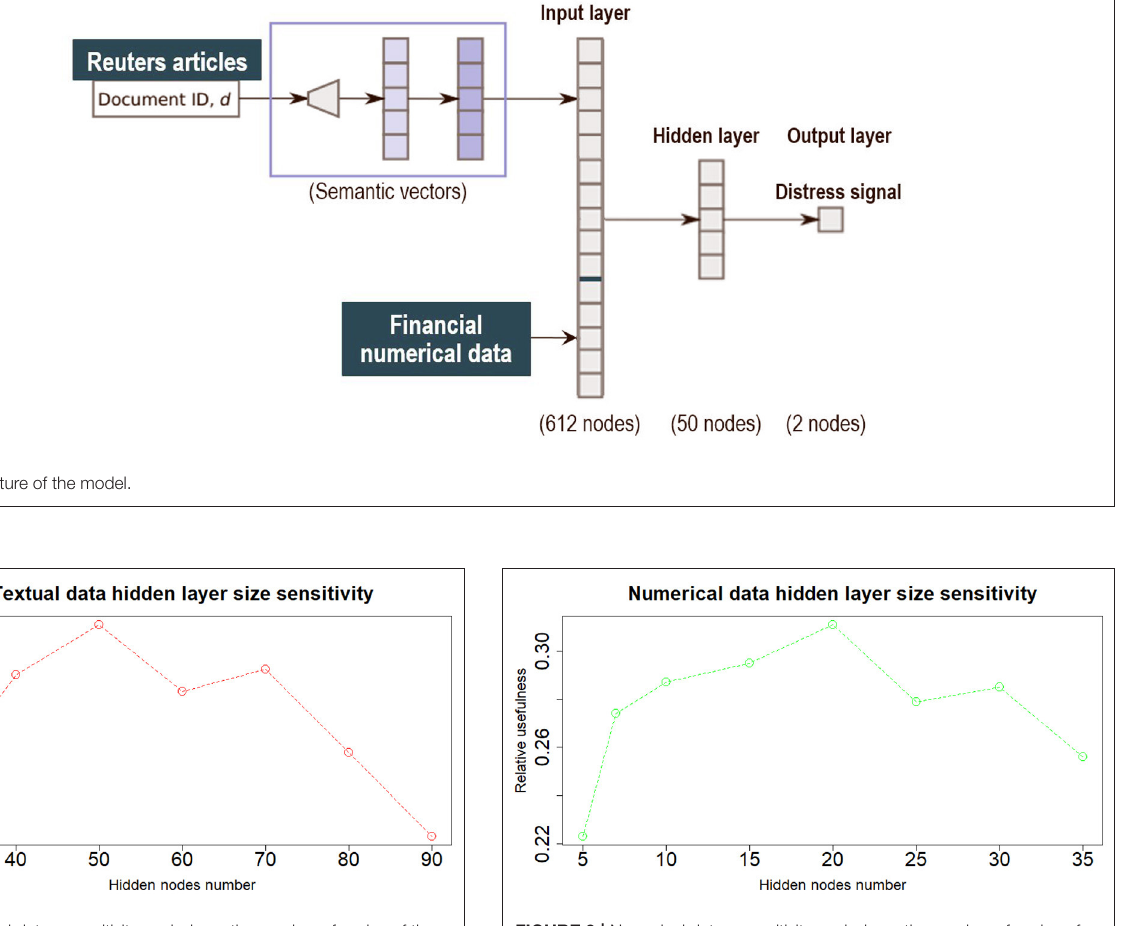
FIGURE 2 | Textual data—sensitivity analysis on the number of nodes of the hidden layer.